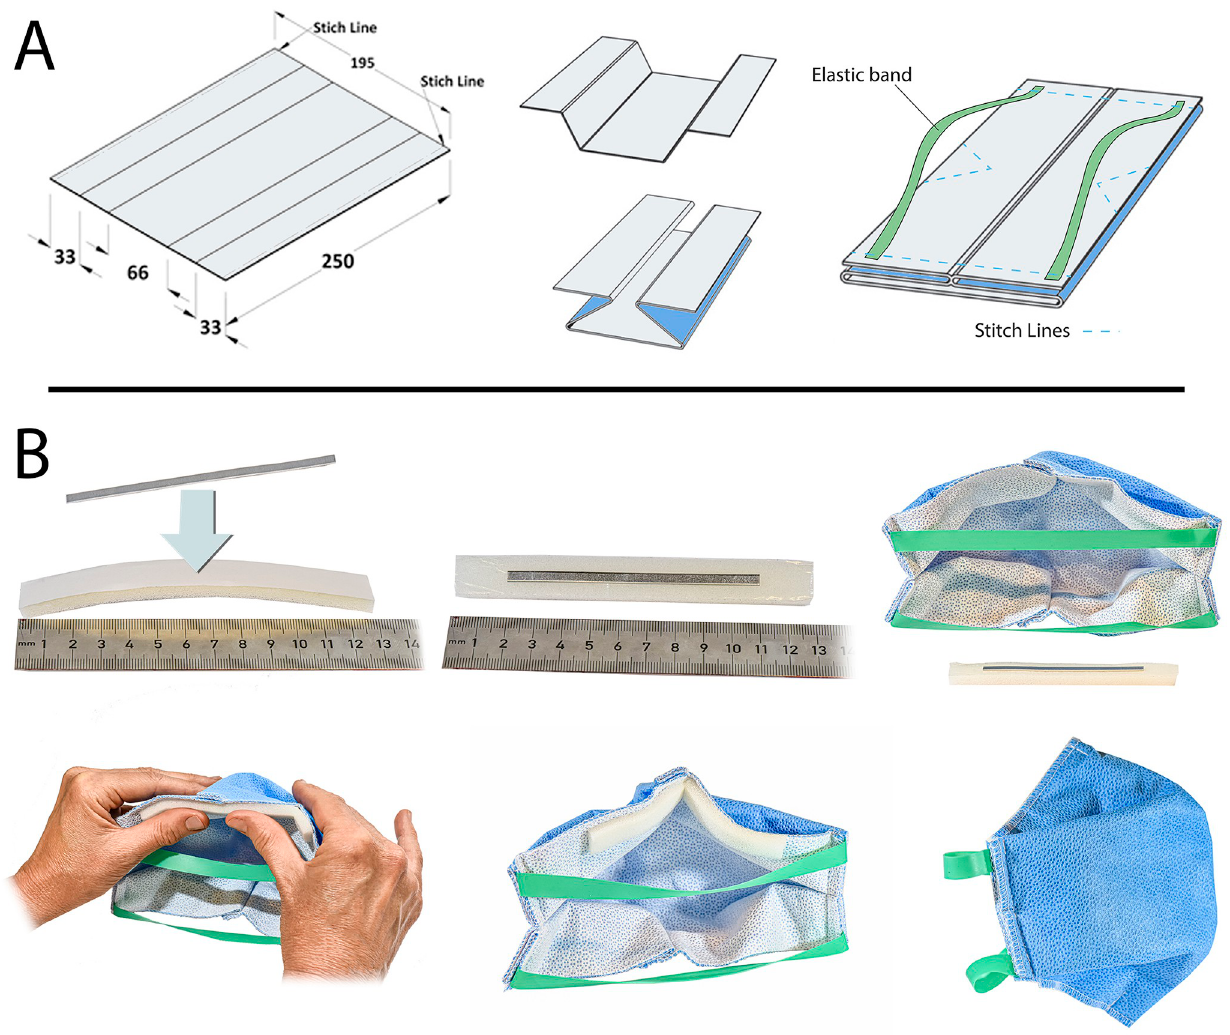
Fig 5. A possible design for fabricating a respirator mask with the sterile isolation material. (A) The layers of the Halyard sterile isolation material are attached by a stitch line on both longitudinal lengths of the sheets. The sheet is folded to provide alignment with the face, and thereby ensure the respirator mask has an adequate fit when worn. The elastics (Resistance Band, Matchu Sport BV) is laser-cut to a width of 13/32 inch (10mm), and a length of 7 7/8 inch (200mm) and attached at the inside of the respirator mask. A single stitch line at the bottom ensures that the surface of the respirator mask stays separated from the mouth and allows to adjust the size of the respirator mask for -and by- anybody. (B) For the nose clip a 0.5mm thick aluminum strips (Al 99.5%, 1050A) is used, cut to a length of 3 1/2 inch (90mm) and a width of 5/32 inch (4mm). A neoprene strip with adhesive is used to hold the noseclip in place, and adhered to the inner-top side of the respirator mask. The fit of the mask was tested using an FT-30 Fit Test from 3M.